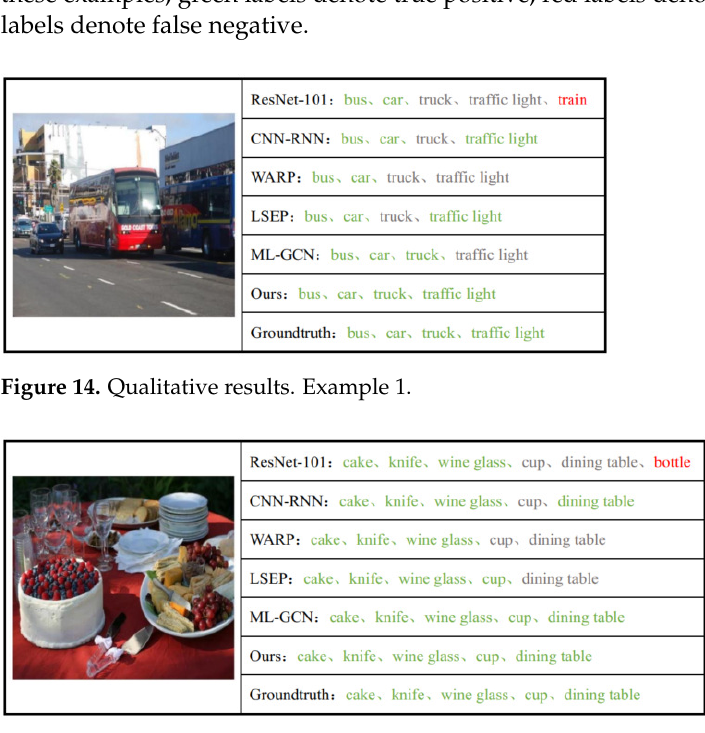
Figure 15. Qualitative results. Example